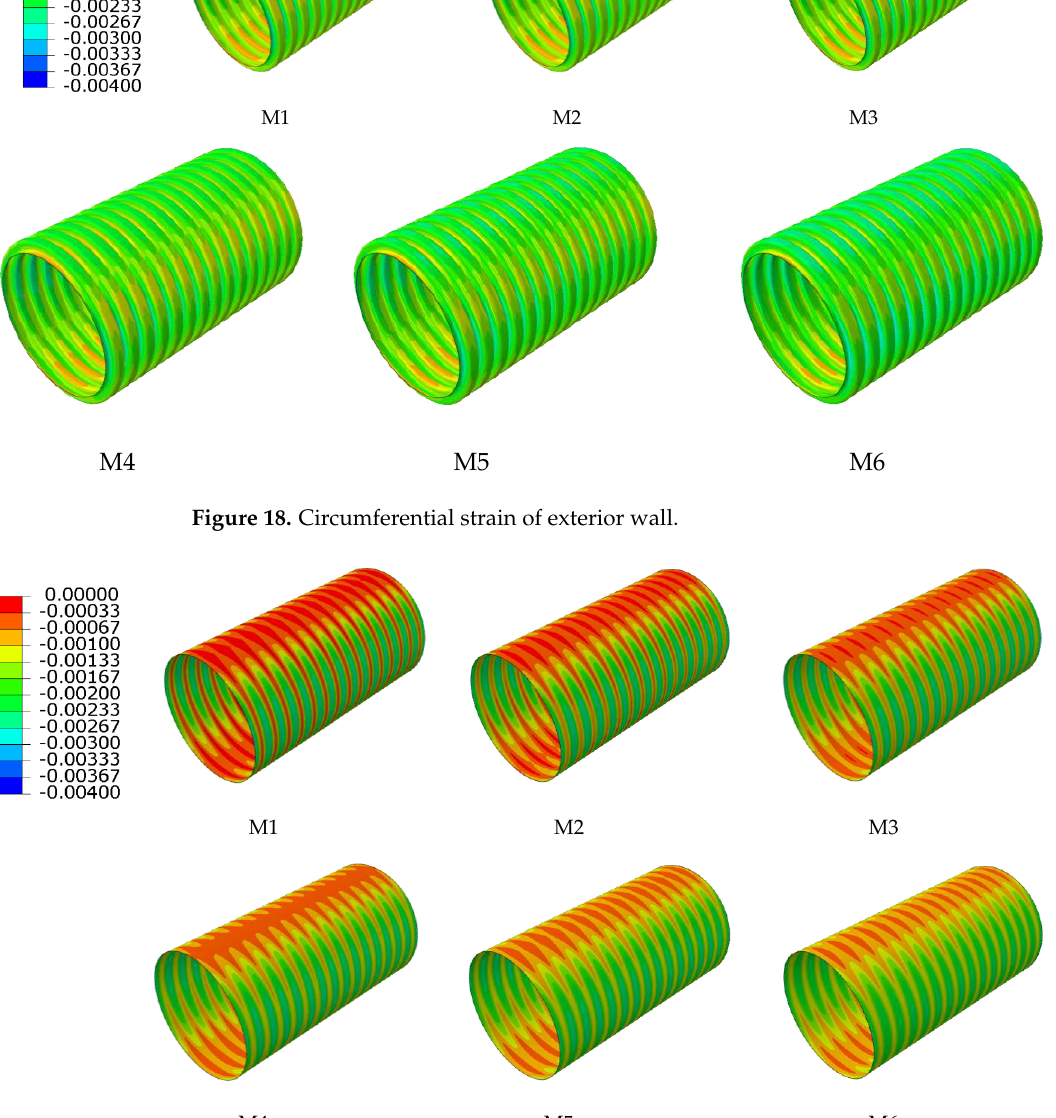
Figure 19. Circumferential strain of interior wall.